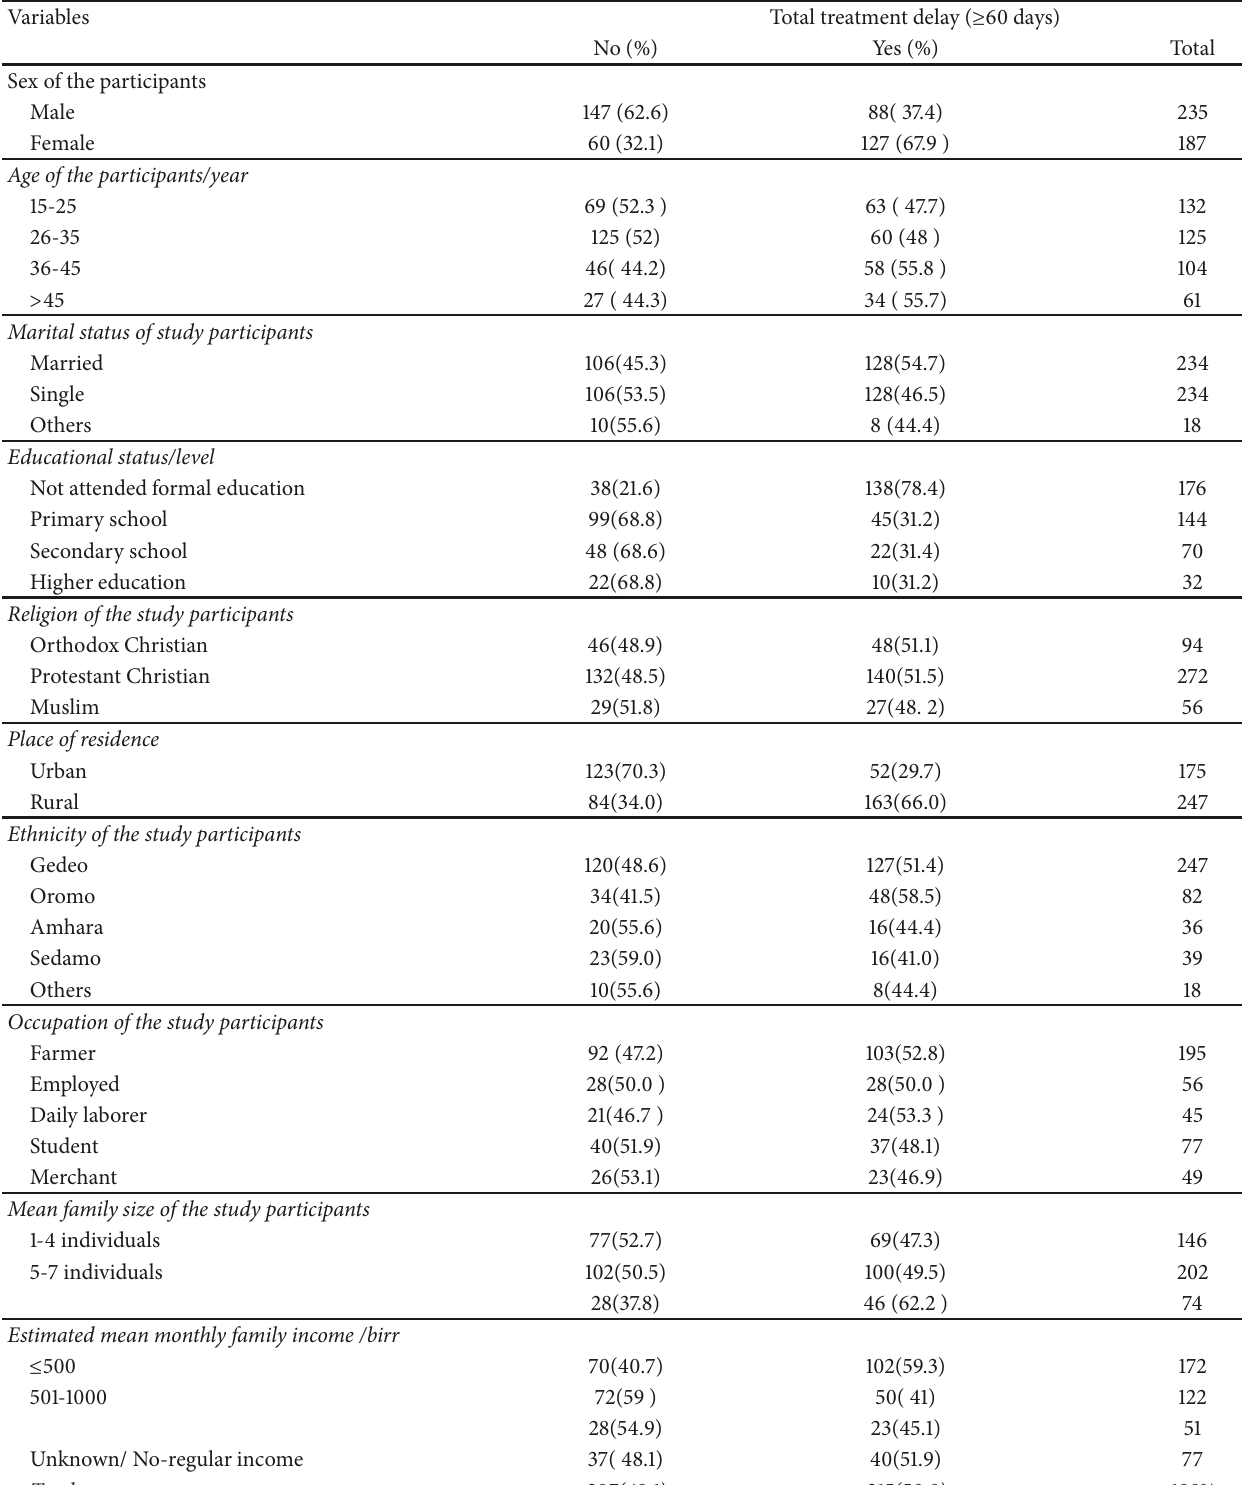
Table 5: Distribution of total treatment delay among sociodemographic characteristics of the study participants in selected health facilities of Gedeo Zone, Southern Ethiopia,